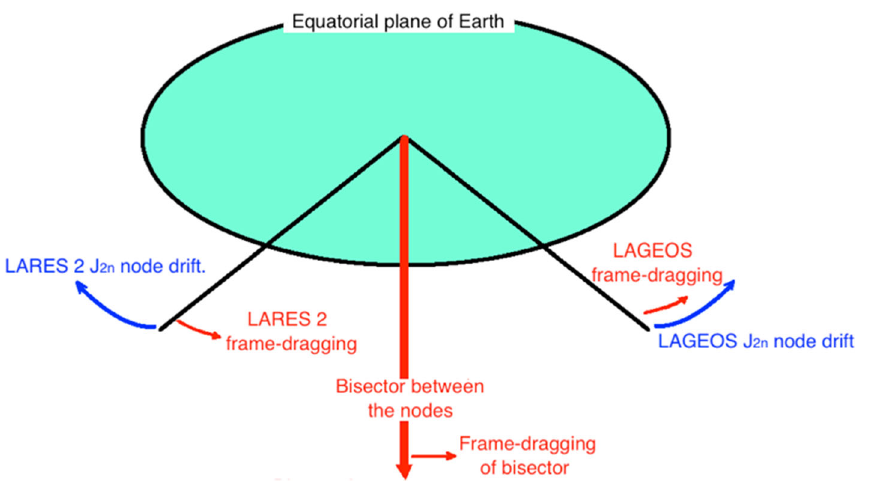
Fig. 2 The concept of the LARES 2 space experiment to accurately test frame-dragging. In this figure is represented the drift of the nodal lines of LARES 2 and LAGEOS. The secular drift, due to the Earth’s even zonal harmonics, is equal and opposite for these two satellites with supplementary inclinations. However, frame-dragging produces a drift of their nodal lines which is the same for both satellites, both in magni-